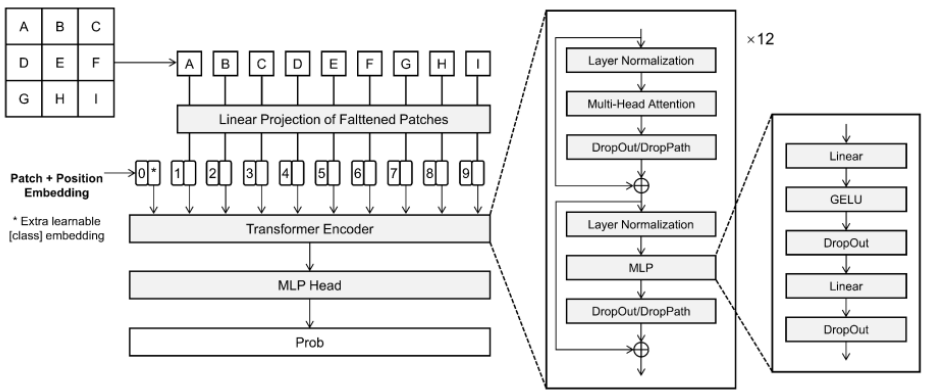
Figure 5. Vision transformer network